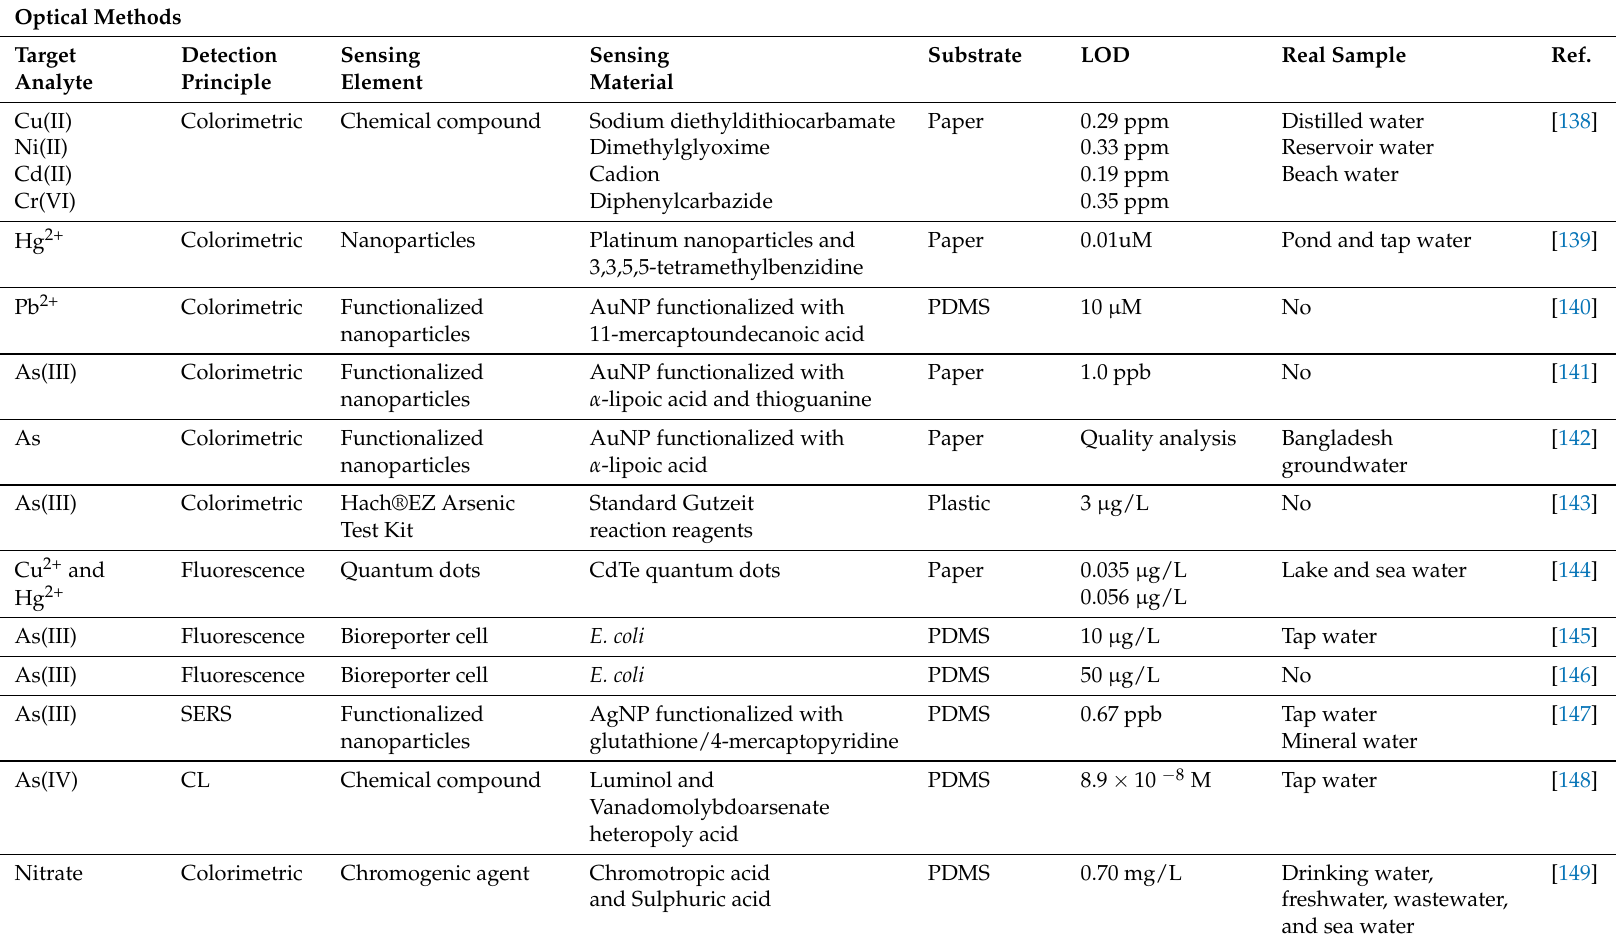
Table 4. Comparison of optical